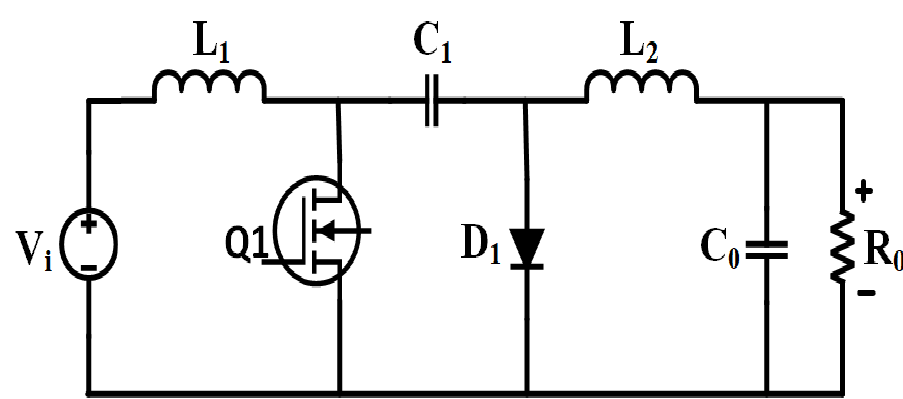
Figure 8. DC-DC Cuk converter.